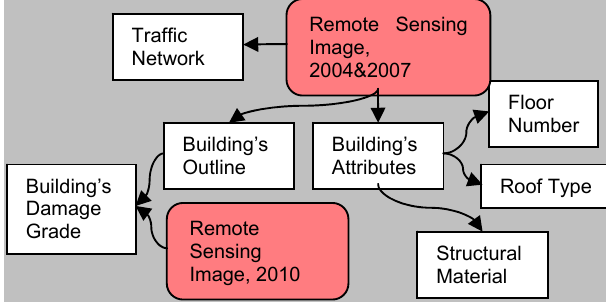
Figure 7 Workflow of information extraction